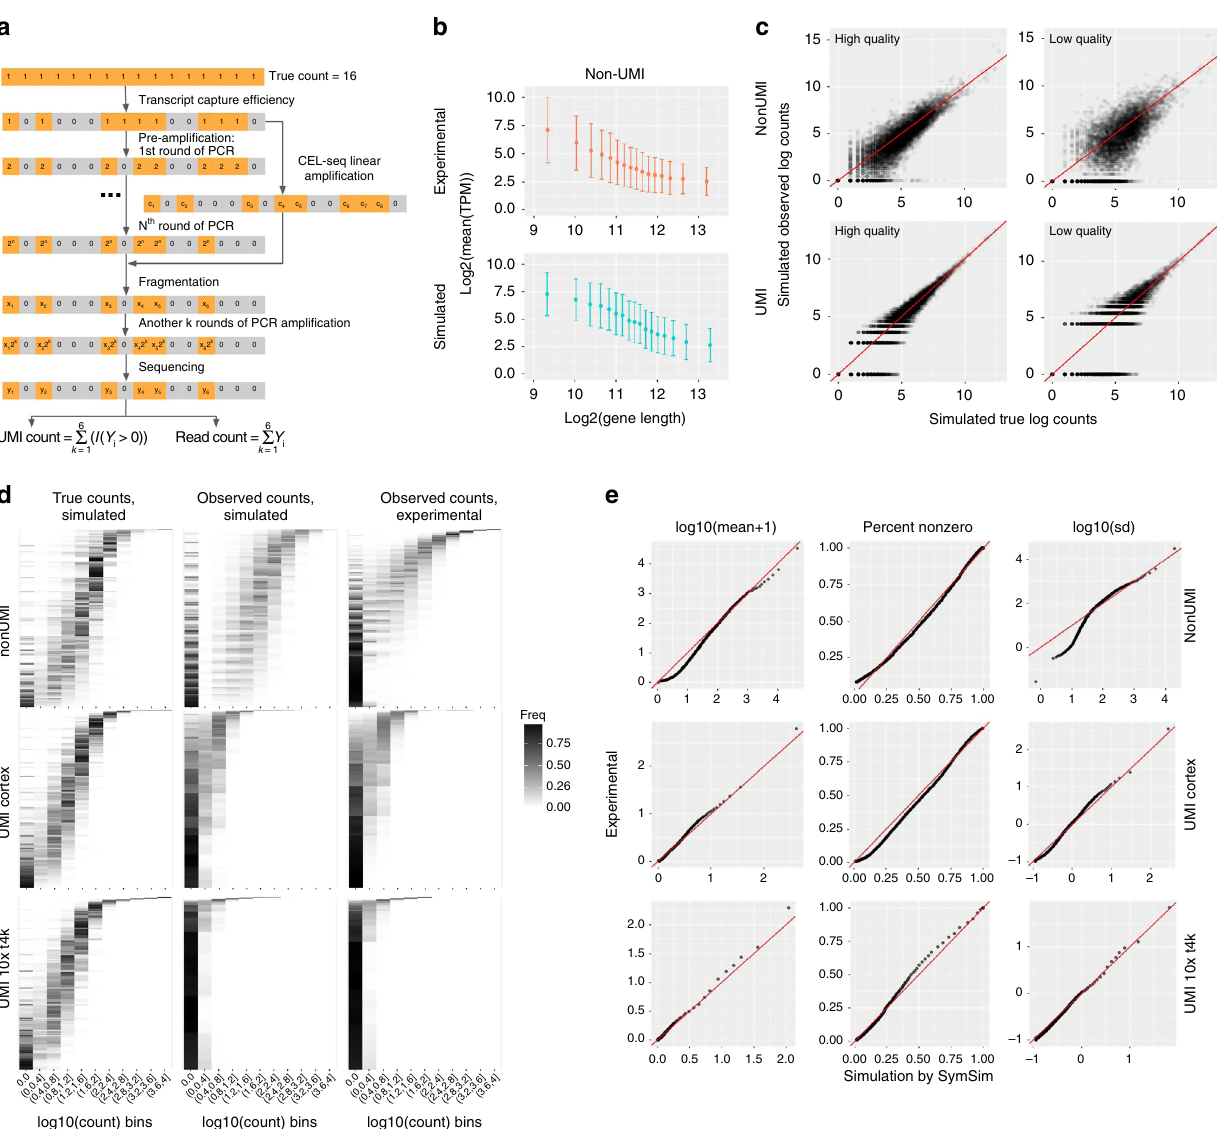
Fig. 4 Technical variation. a A diagram showing the work fl ow of adding technical variation to true simulated counts. Each gray or orange square represents a molecule of the same transcript in one cell. We implement the following steps: mRNA capturing, pre-ampli fi cation (PCR or linear ampli fi cation of the cDNAs), fragmentation, ampli fi cation after fragmentation, sequencing, and calculation of UMI counts or read counts. Details of these steps can be found in Methods. b Gene length bias in both simulated and experimental data for the non-UMI protocol. Error bars represent the ranges of (mean-SD, mean + SD), where SD means standard deviation. c Scatter plots comparing true counts and observed counts obtained through: (1) non-UMI, good parameters ( α = 0.2, MaxAmpBias = 0.1, Depth = 1e6) for high quality data; (2) UMI, good parameters ( α = 0.2, MaxAmpBias = 0.1, Depth = 5e5) for high quality data; (3) non- UMI, bad parameters ( α = 0.05, MaxAmpBias = 0.2, Depth = 1e6) for low quality data; (4) UMI, bad parameters ( α = 0.04, MaxAmpBias = 0.2, Depth = 5e5) for low quality data. d 2D transcript counts histogram heatmap of UMI and non-UMI simulated true counts and simulated observed counts, generated with parameters which best match the input experimental counts, and histogram heatmaps of the respective experimental counts (non-UMI Th17, UMI cortex and UMI 10x t4k datasets). e Q – Q plots comparing the mean, percent non-zero and standard deviation in experimental counts and SymSim simulated observed counts respectively for the non-UMI, UMI cortex and UMI 10x t4k datasets. A good match is indicated by most of the dots falling close to the red line. Data used to plot b – e can be found in Source